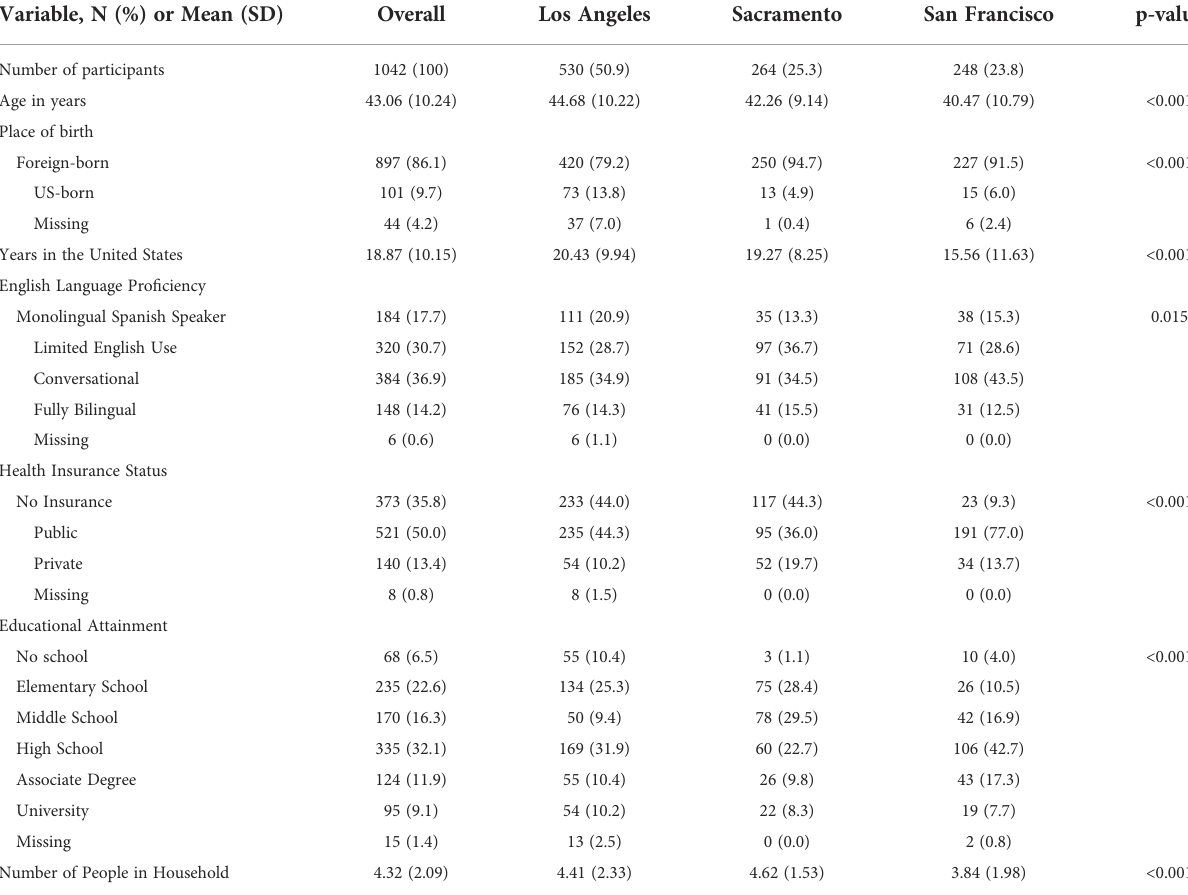
TABLE 1 Demographic characteristics of 1042 ‘ Tu Historia Cuenta ’ program participants in California overall and by recruitment area. Variable, N (%) or Mean